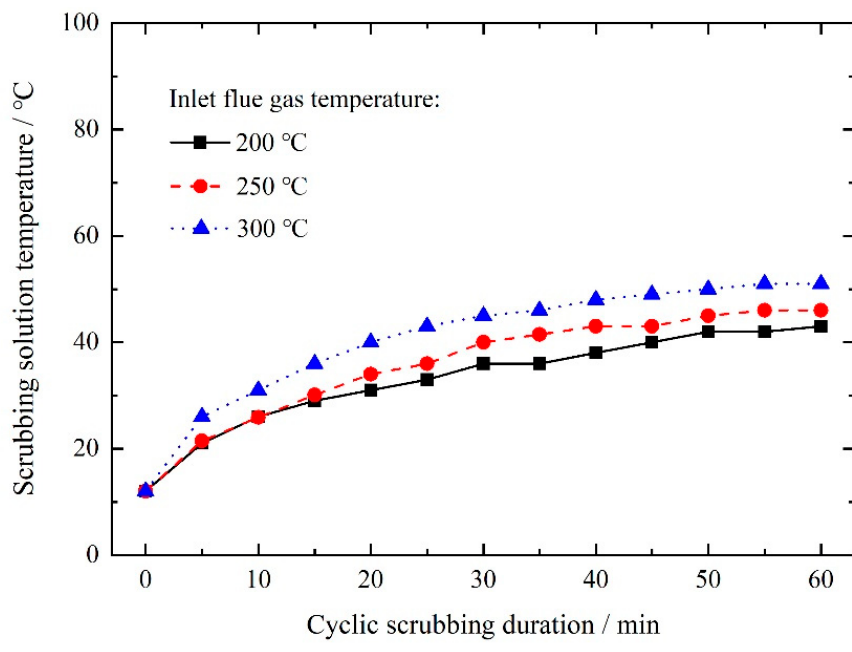
Figure 5. The e ff ects of wet scrubbing on flue gas Figure 5. The effects of wet scrubbing on flue gas temperatures.